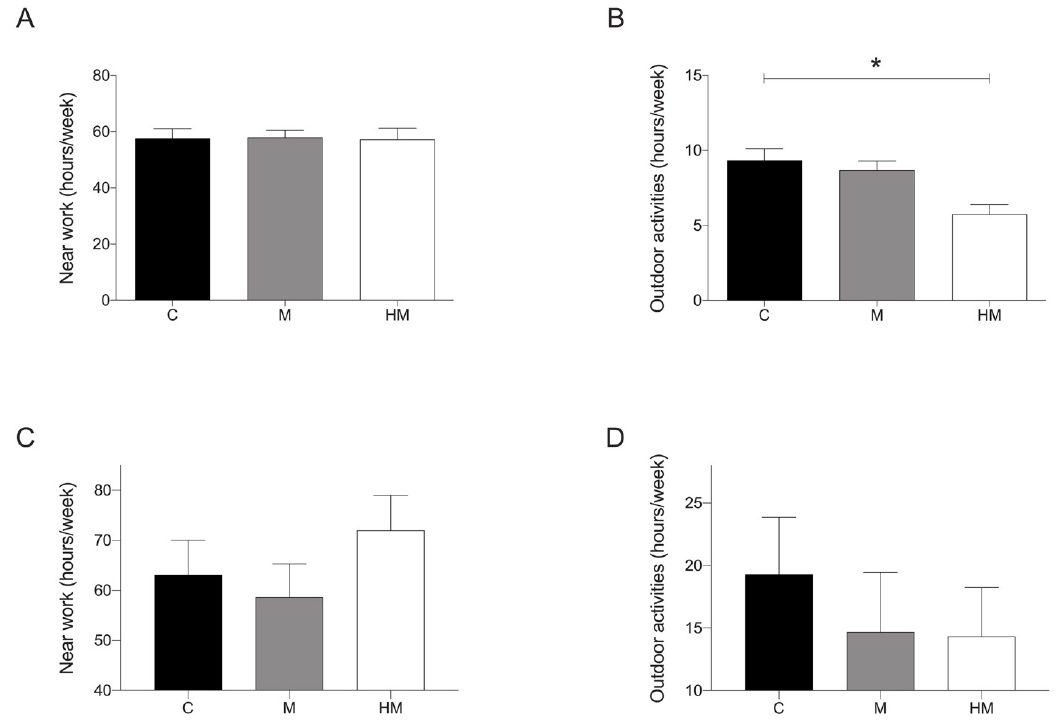
Figure 1. Analysis of environmental factors in both student cohorts. ( A ) Medical students: analysis of weekly hours of near work activities in control group vs. myopic and HM groups. ( B ) Medical students: analysis of weekly hours of outdoor activities in control group vs. myopic and HM groups. ( C ) Environmental science students: analysis of weekly hours of near work activities in control group vs. myopic and HM groups. ( D ) Environmental science students: analysis of weekly hours of outdoor activities in control group vs. myopic and HM groups. C: control group (>1.00 D); M: myopic group ( ≤ 1.00 D); HM: High myopia ( ≤− 6.00 D or AL >26 mm). Significance p < 0.05. * p < 0.05